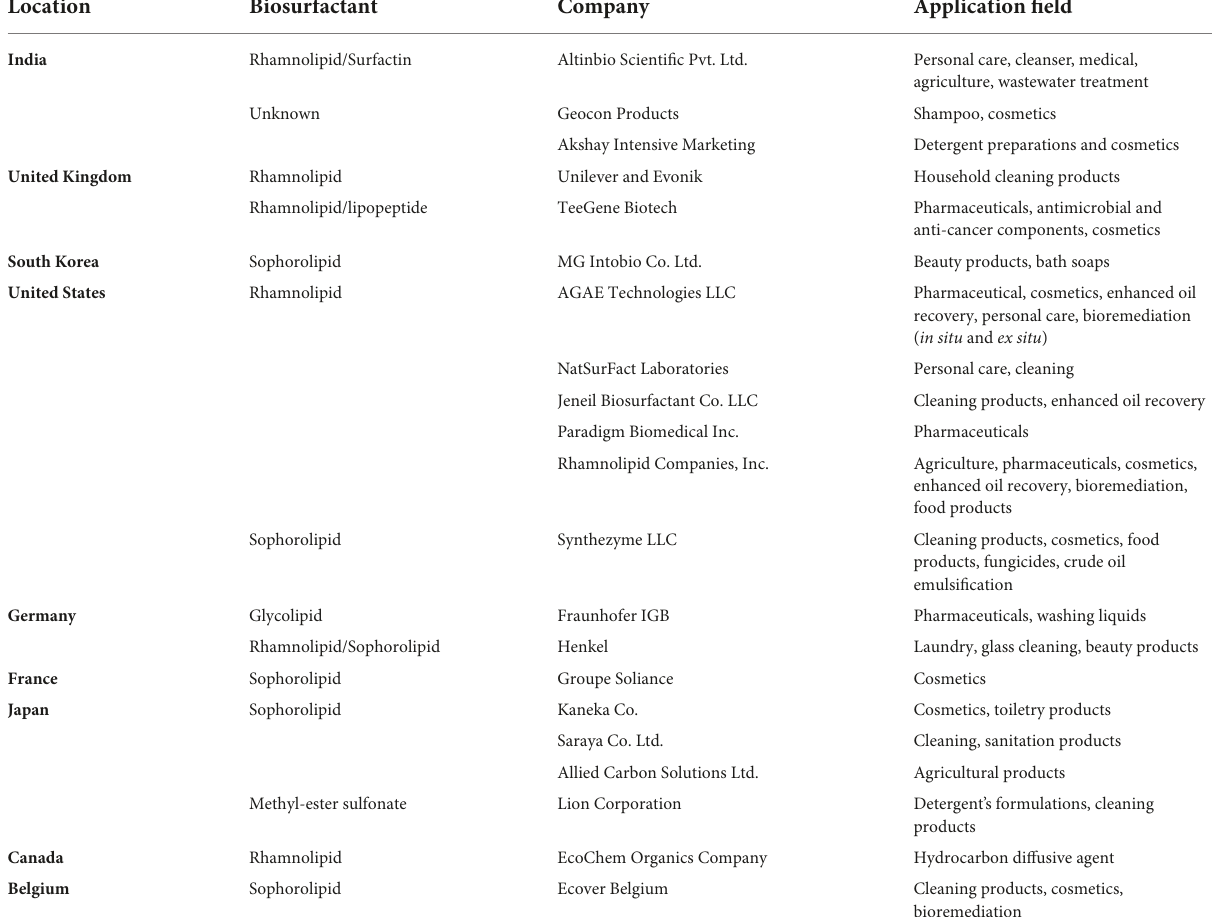
TABLE 5 Worldwide manufacturers of